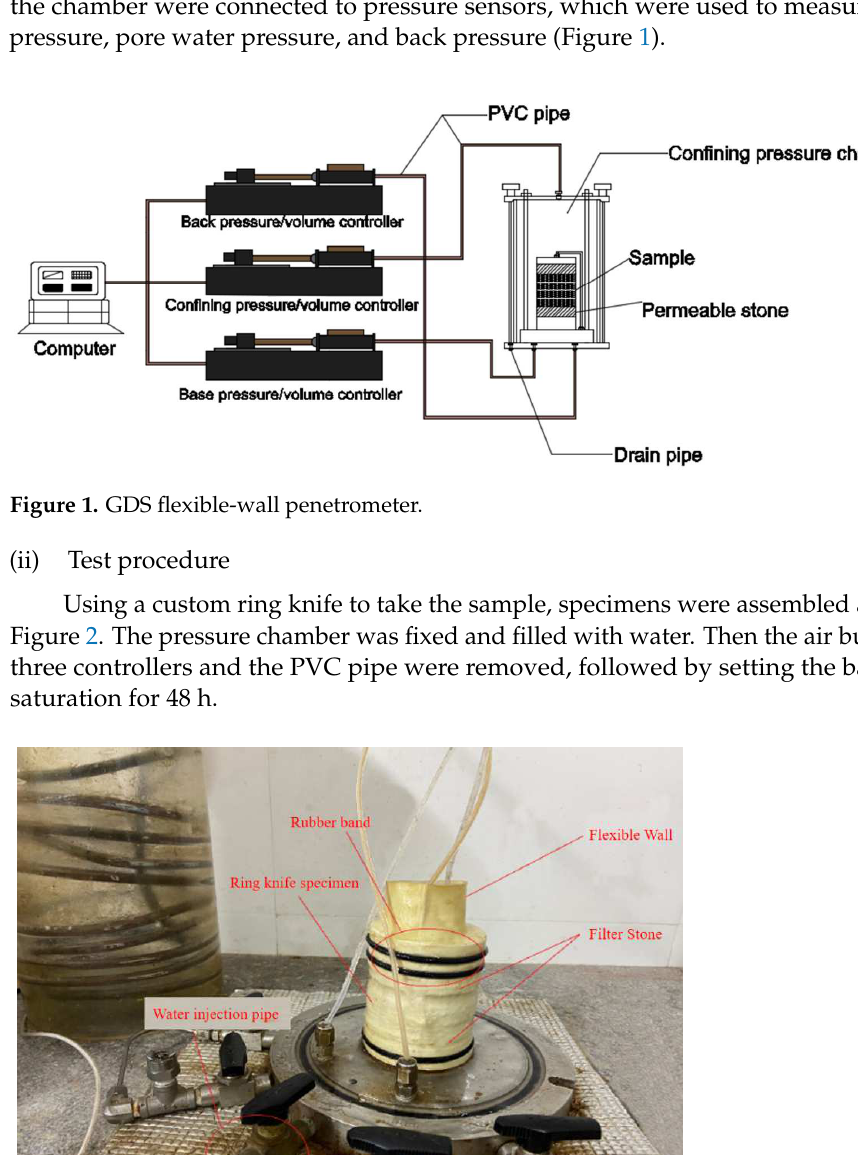
Figure 2. Physical picture of transparent clay permeability test sample assembly.